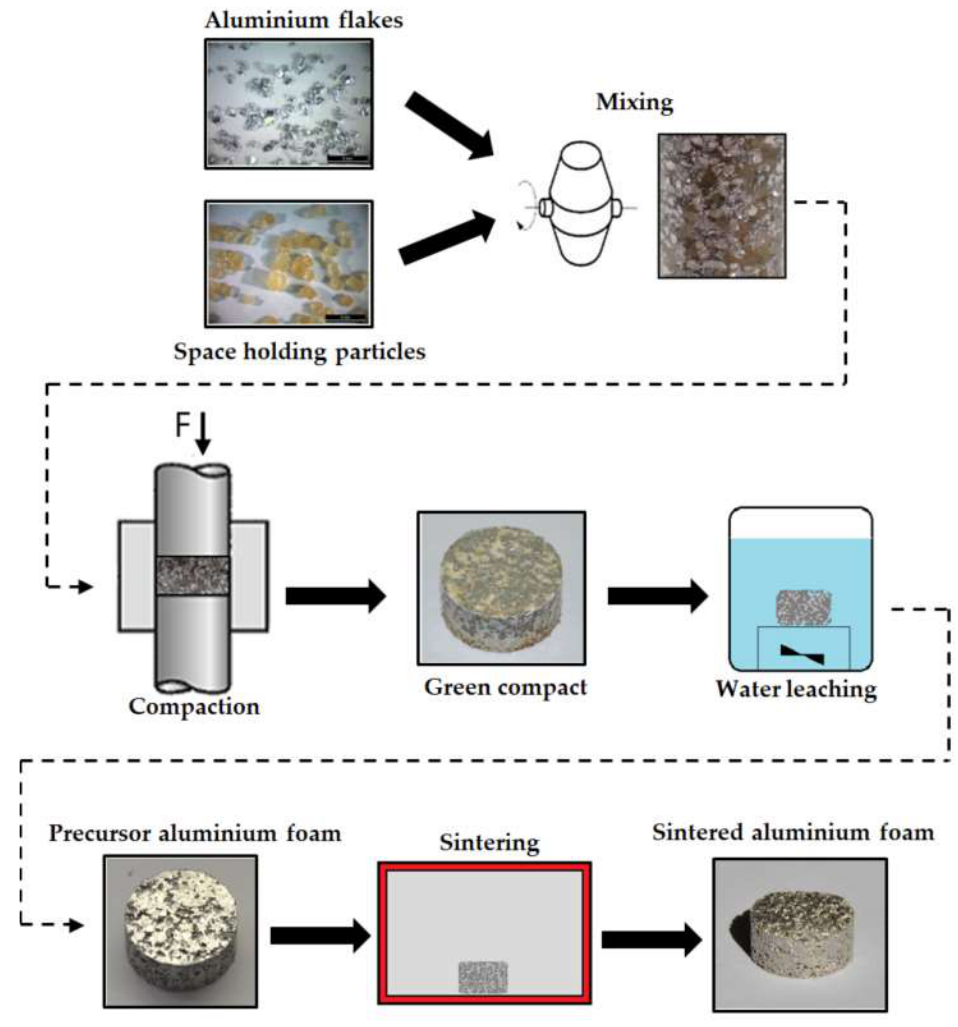
Figure 1. Scheme of the aluminum foam manufacturing procedure.